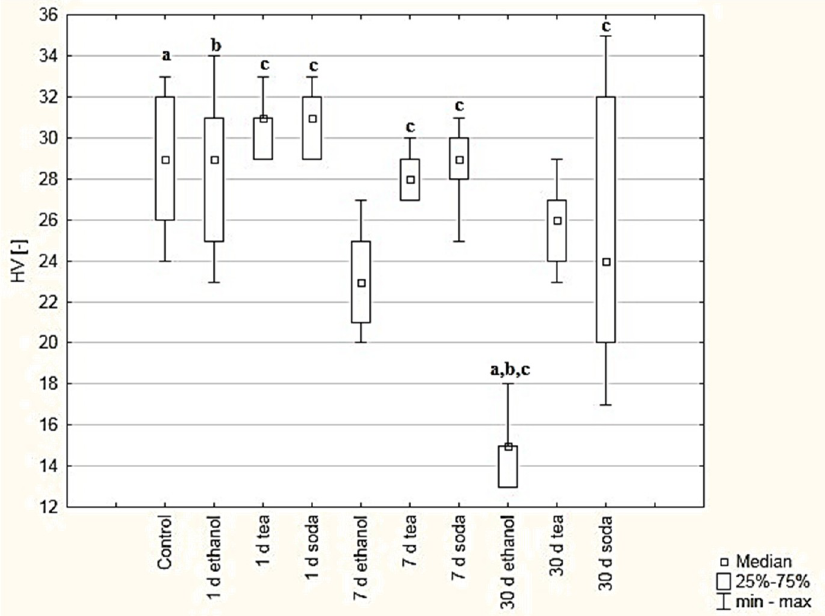
Figure 1. Box and whiskers plot of Vickers hardness of samples. Values were obtained for samples made of Breeze cement treated with ethanol (75%), green tea and baking soda (2.5%) solutions after one, seven or 30 days and samples immersed for seven days in distilled water as control. Statistically significant differences were detected between: (a) Control group vs. 30 days in ethanol solution, (b) 1 day in ethanol vs. 30 days in ethanol solution, (c) 30 days in ethanol solution vs. 1 day in tea solution, 7 day in tea solution, 1 day in soda solution, 7 day in soda solution, 30 days in soda